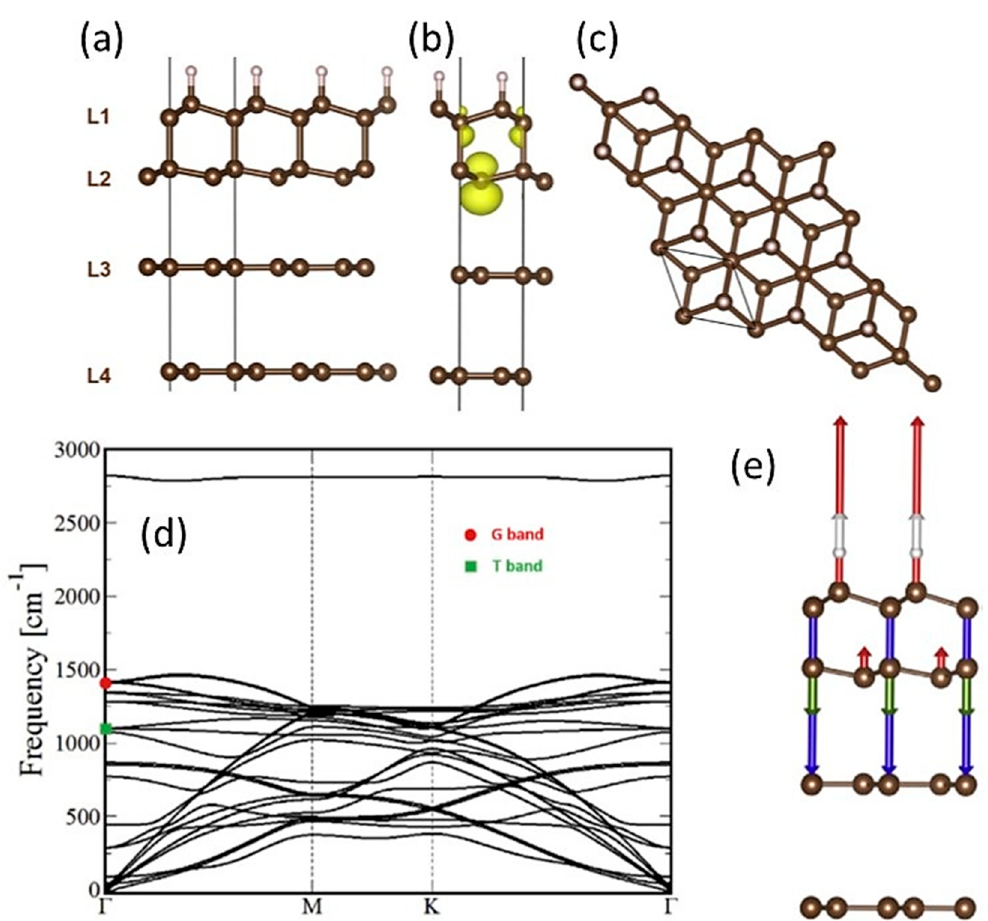
Figure 11. Computed model: ( a , b ) are two side views, and ( c ) is a top view of the upper-layer-hydrogenated FLG used in density functional theory (DFT) calculations with ABBA-stacking graphene [31]. In ( b ) is shown how the pz orbitals are preferably oriented towards the layer underneath (layer L3). The projected structure ( c ) is that of the face-centered cubic of diamond with the unit cell (black lines). ( d ) Phonon dispersion curves of the model in ( a ). ( e ) Corresponding vectors of the atomic vibrations along the normal T mode at 1078 cm − 1 .